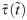
VWF molecule unfolding under the action of a rectangular shear stress profile with various durations.(a) Shear stress impulse τ~(t~) is shown in red, τ~m is its amplitude, and t~G is its duration. (b) Phase trajectory of the solution (Eq (8)) is illustrated by the red line for the shear stress profile from Fig 5a; initial conditions: q = qm, q˙=0. t~E, t~F and t~G are time moments when the image point reaches points E, F and G, respectively. If the duration of the shear stress impulse t~G is greater than that of t~F, the trajectory crosses the part of the separatrix AS, and the molecule can unwind to its full length. |q˙A| is the absolute value of the momentum at point A.